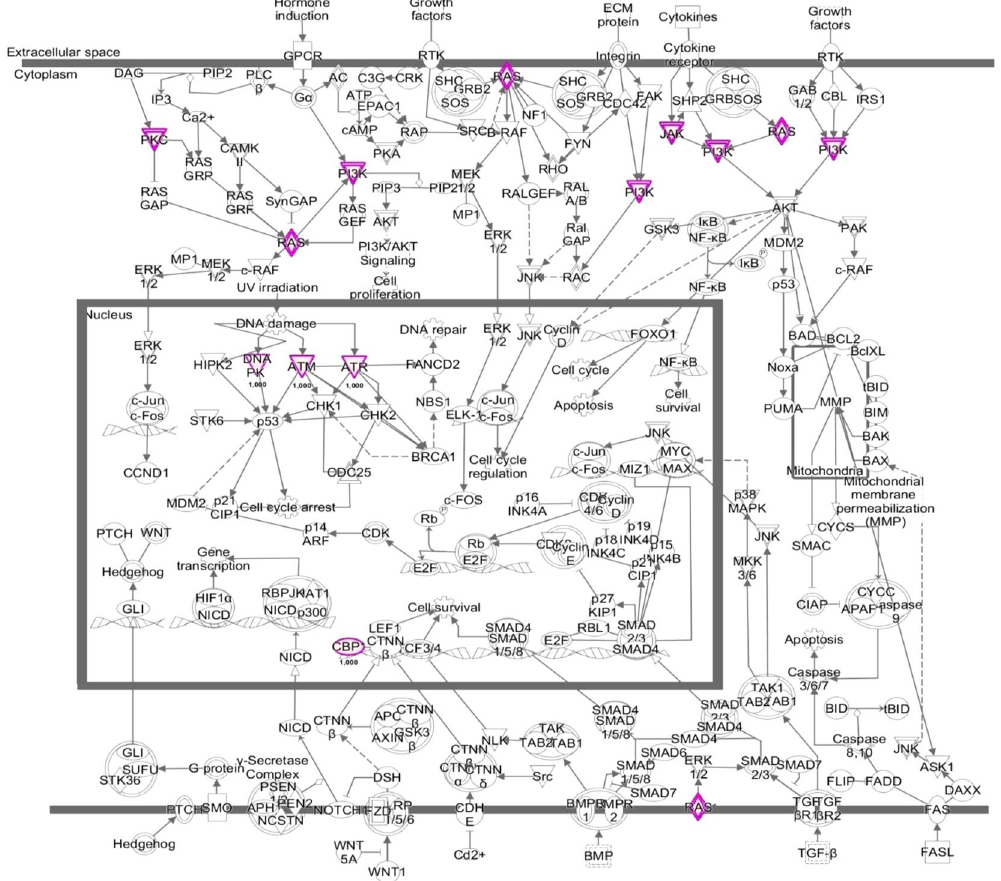
Figure 8. Canonical Pathway of ‘Molecular Mechanisms of Cancer’ (IPA, p-value 0.0199). Color red: the darker, the more damaging mutations were found by exon sequencing. Color pink: overlays within dataset of 282 damaging mutations. Color pink double bordered: shows more than one gene within a complex. Genes from the dataset involved in the pathway are: PRKDC, NRAS, TYK2, CREBBP, PIK3C2G, ATR, JAK2, PRKD3,